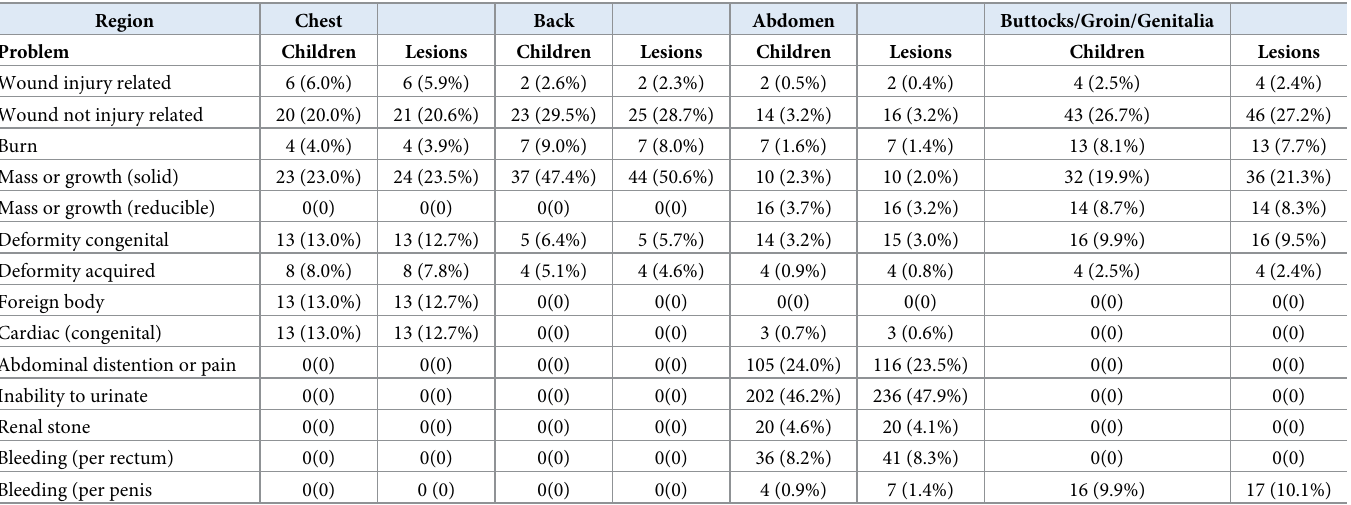
Table 4. Lesions on chest, back, abdomen, Buttocks/Groin/Genitalia.